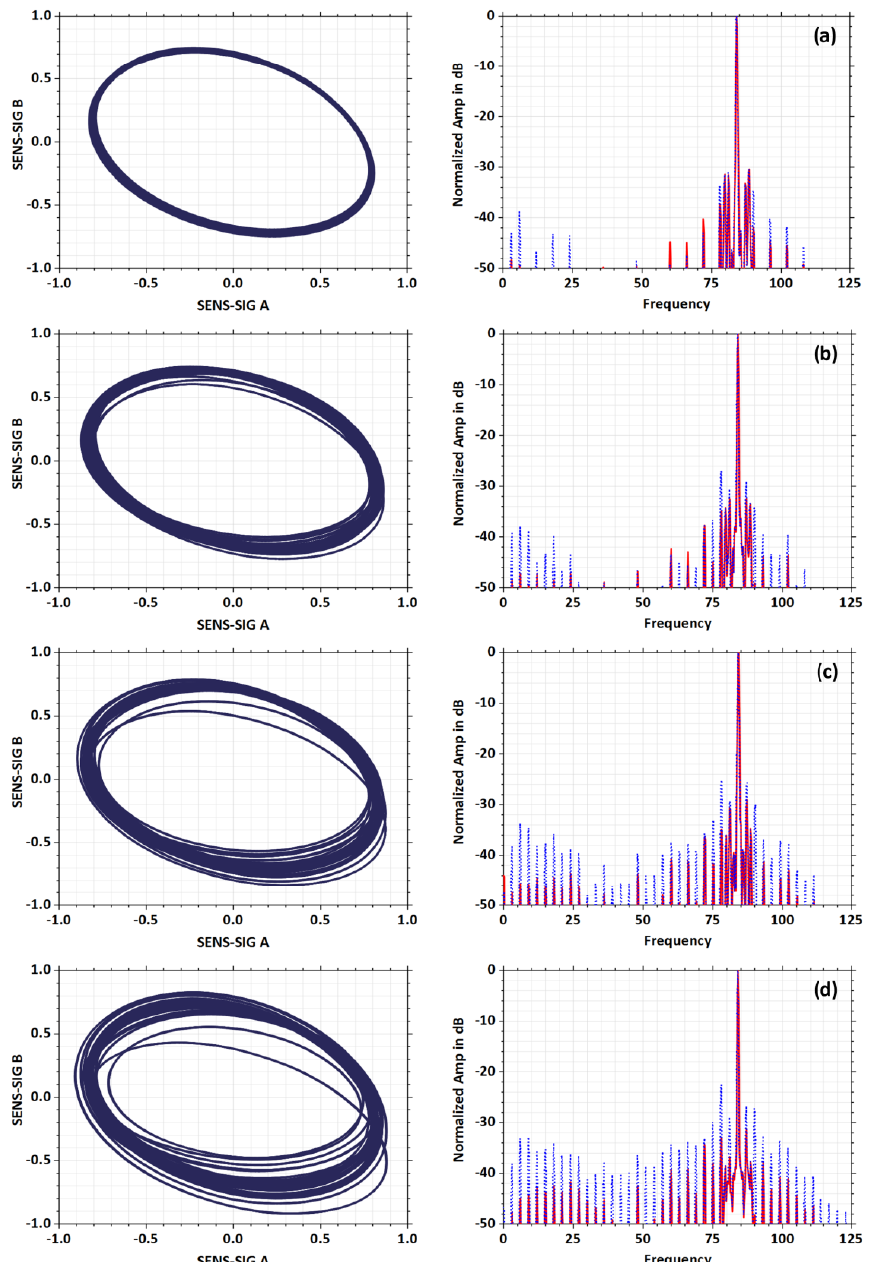
Figure 22. Comparison of FFT and oval patterns for failures in segment of end-ring: ( a ) Refer- ence oval pattern for rotor without defect; ( b ) 33% Cross-Section Loss; ( c ) 67% Cross-Section Loss; ( d ) 100% Cross-Section